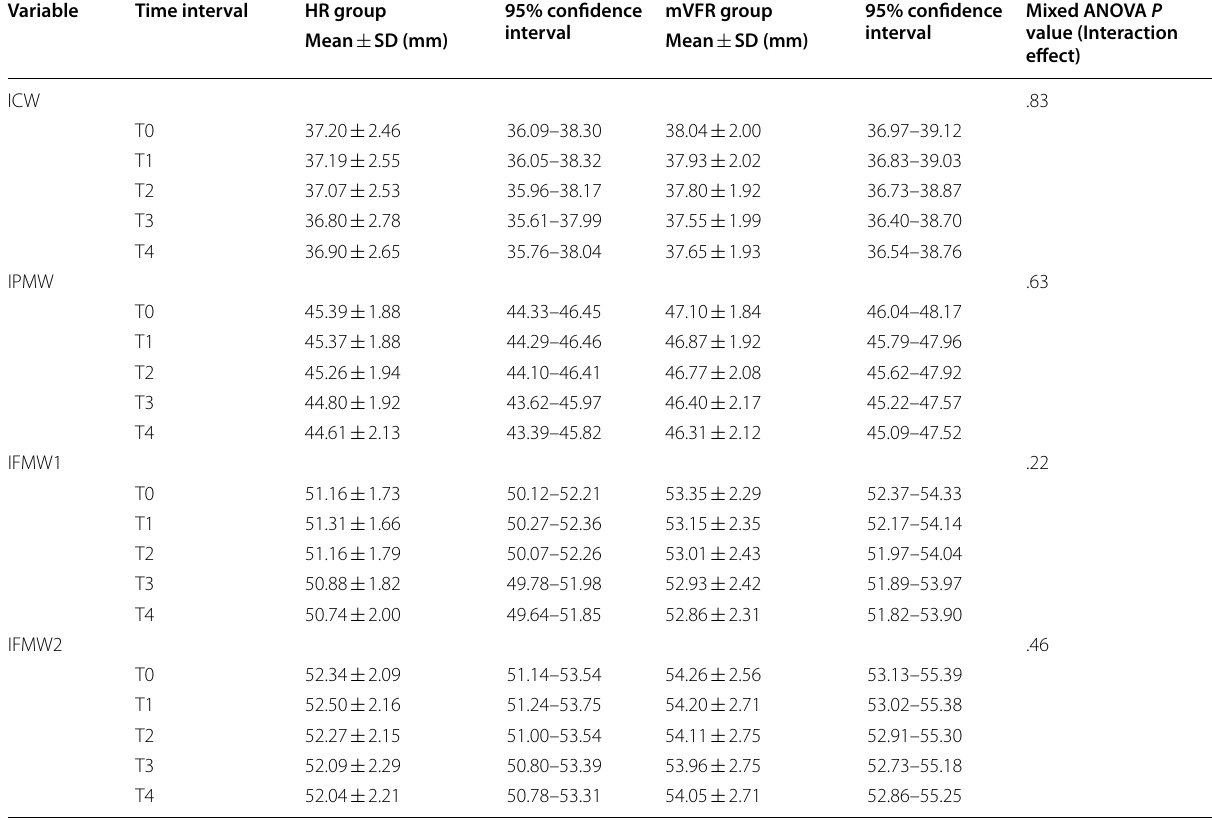
Table 3 Mixed ANOVA interaction